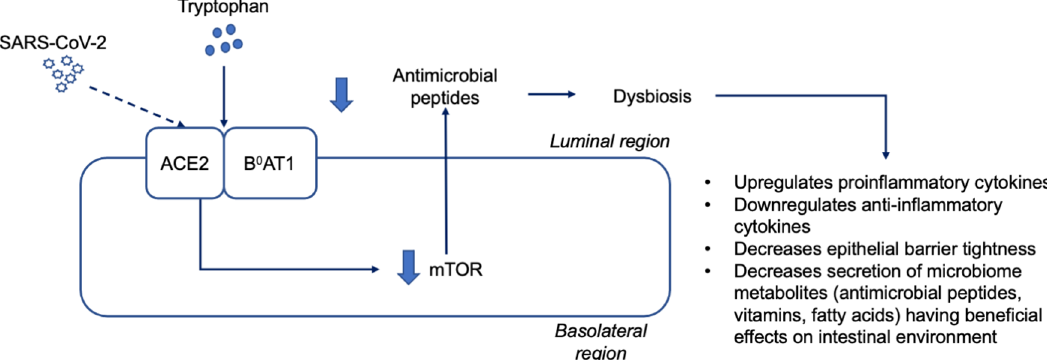
Figure 5. Interrelation between the digestive system and other systems as a proposed mechanism of GI symptoms in SARS-CoV-2 infection. GIT symptoms during the COVID-19 course can be influenced by the virus infectionsinseveralsitessuchasintheCNS,lungandliver.Theinfectionsoccurringinthoseorganscanbesensedby theGITleadingtotheemergenceofthesymptoms.Severalaxesareinvolvedinthisinterrelationshipsuchasthegut- brain axis which is mainly mediated by the enteric nervous system, gut-lung axis involving the movement of CCR9- CD4+fromthelungtotheintestinedrivenbytheCCL25,andgut-liveraxiswhichisconnectedthroughtheportalvein and biliary